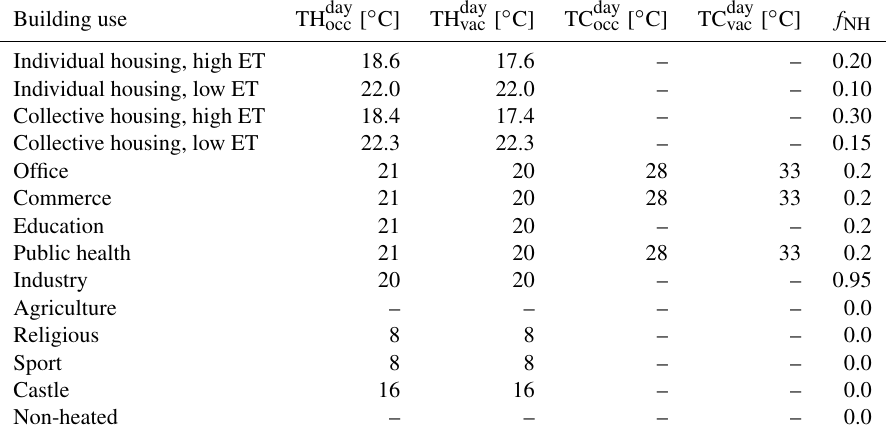
Table A3. Design temperature for heating (TH) and air conditioning (TC) as well as non-heated fraction ( f NH ) of the building. The values for the “night” are assumed to be equal to the values during the day when the building is vacant. A “–” indicates that no heating or air conditioning is taken into account. For the residential buildings, the values are based on the ENERGIHAB survey for the two classes of the efficiency tendency (ET) indicator defined by Bourgeois et al.